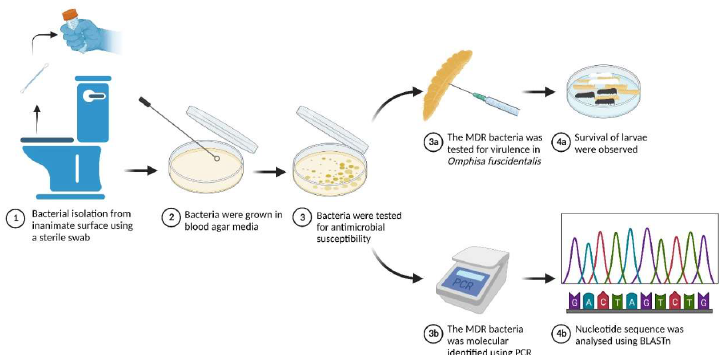
Figure 1. The schematic method of this study is illustrated in this figure. Bacteria were isolated from inanimate surfaces of various sources at a medical university on blood agar. The grown bacteria were then tested for antimicrobial susceptibility. The MDR bacteria, TB1 isolate, was then further tested for molecular identification and virulence determination. This figure was created with BioRender.com under agreement number “ JH24RZTNDZ “.